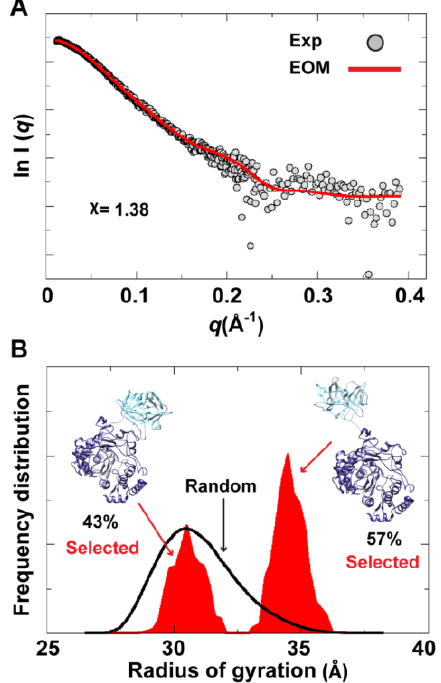
Figure 11. Ensemble Optimization Method (EOM) analysis suggested the presence of two conformations for 3CD in solution. ( A ) The scattering profile calculated from the selected EOM sub-ensemble (red) is in good agreement with the experimental data (grey) as indicated by the low χ-value. ( B ) Shown is the EOM radius of gyration distribution ( R g ) of the initial random pool (black line) and the selected sub-ensemble (red shades) for 3CD; the 3C-domain adopts different conformations relative to the 3D-domain in the sub-ensemble. The selected sub-ensemble corresponds to two conformers: an extended conformer that has no interdomain interactions and a compact conformer with interdomain interactions; the extended one is slightly preferred, contributing 57% to the total scattering. The two conformers are displayed in the inset.